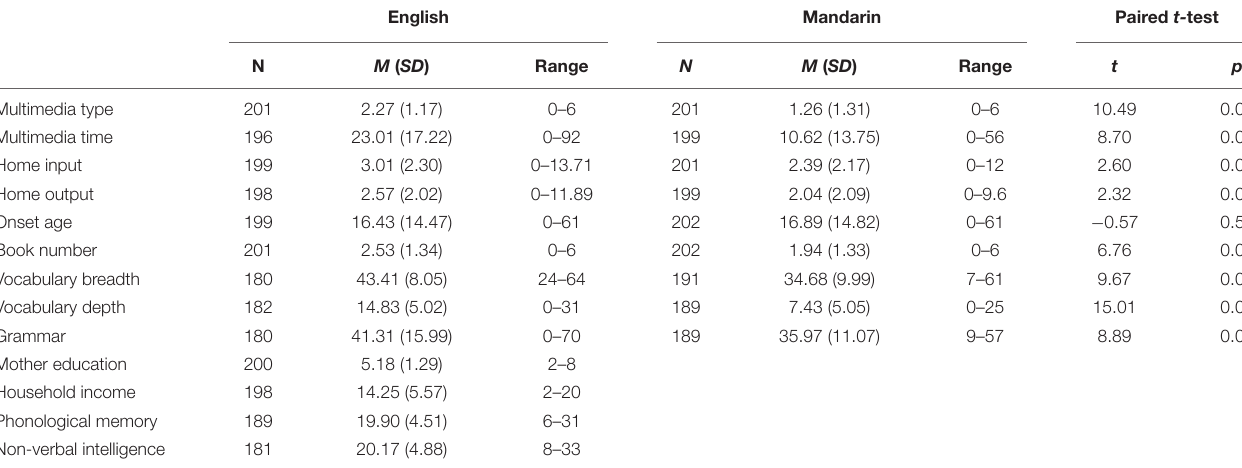
TABLE 1 | Descriptive statistics and paired t -tests of the bilingual language environment and learning